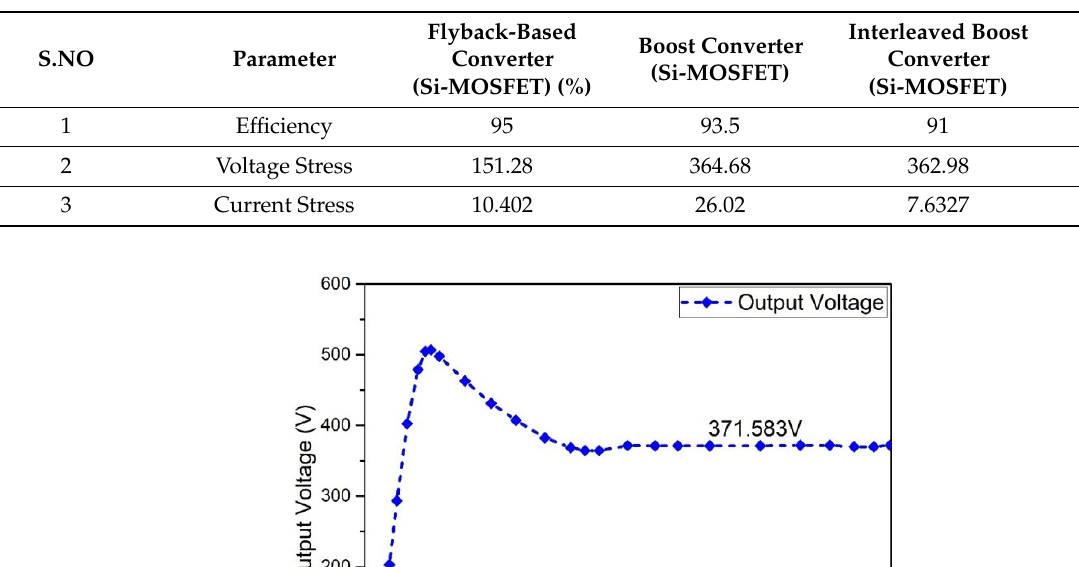
Characteristics of Flyback boost, simple boost, and interleaved boost converters Si-MOSFET/GaN-HEMT.